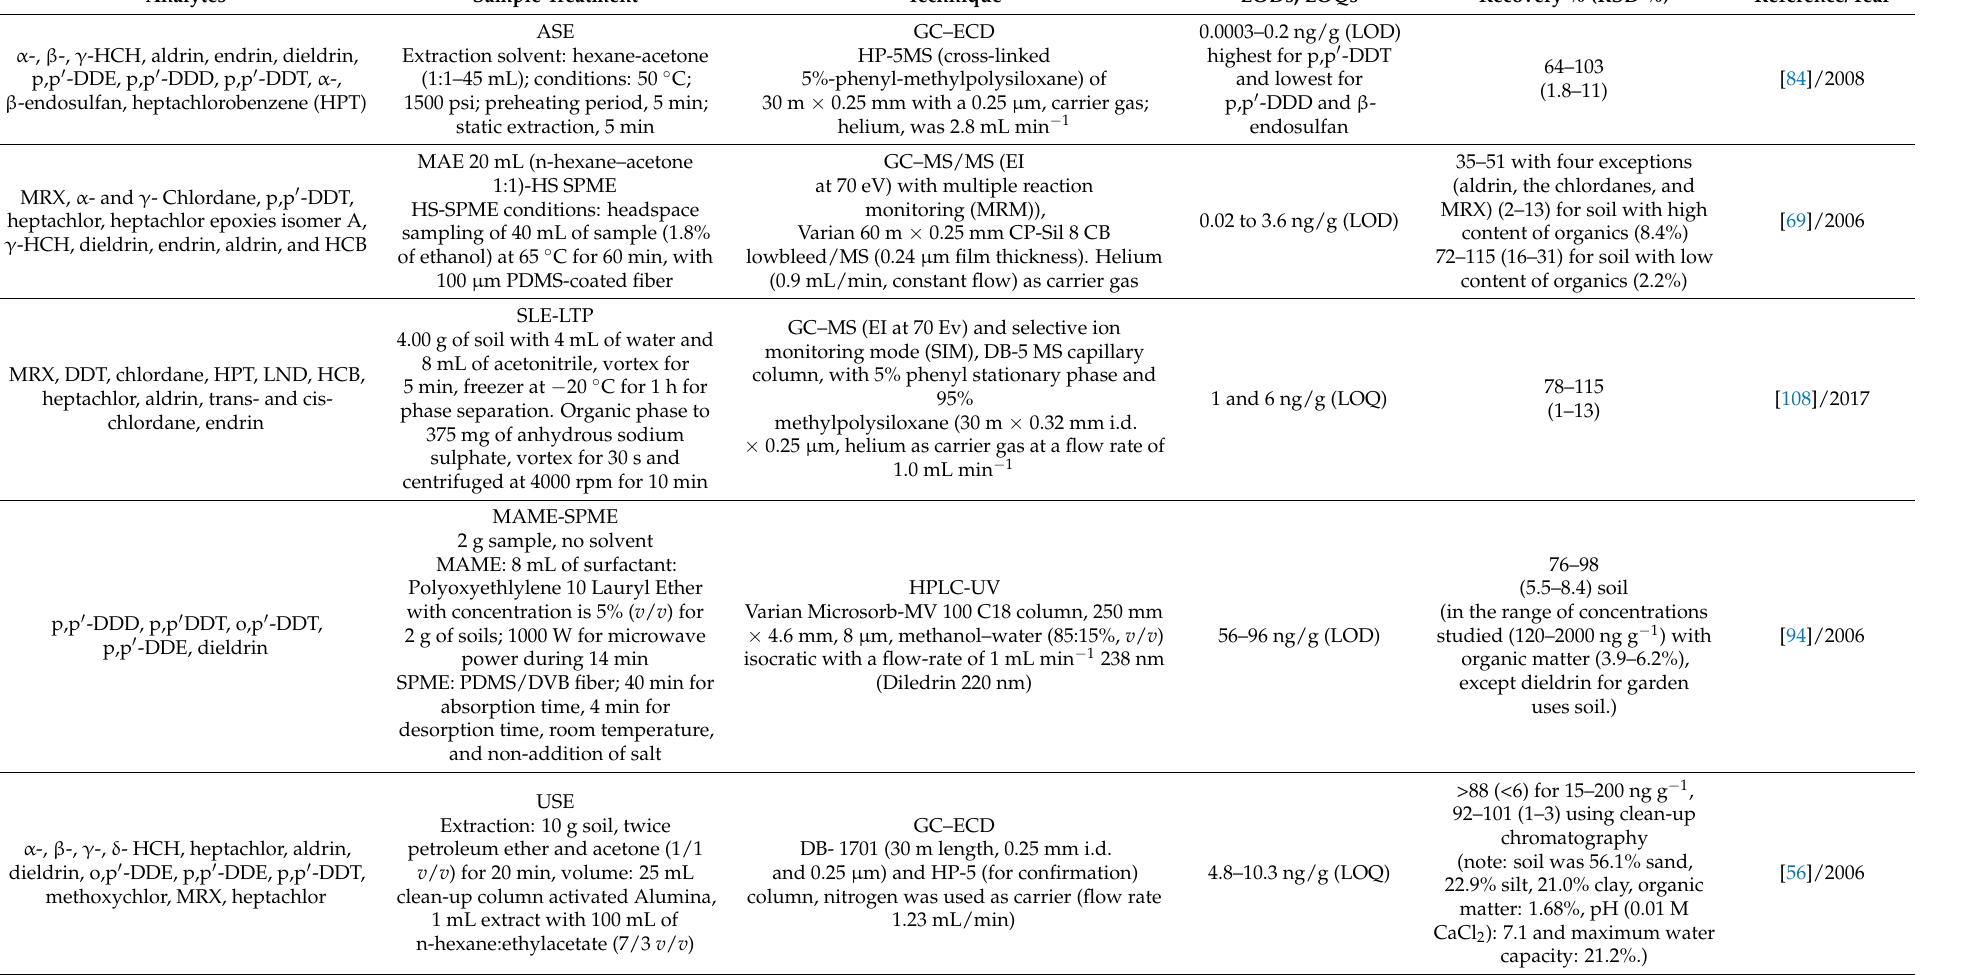
Table 2. Analytical methods used to analyze the most studied OCPs in solid environmental